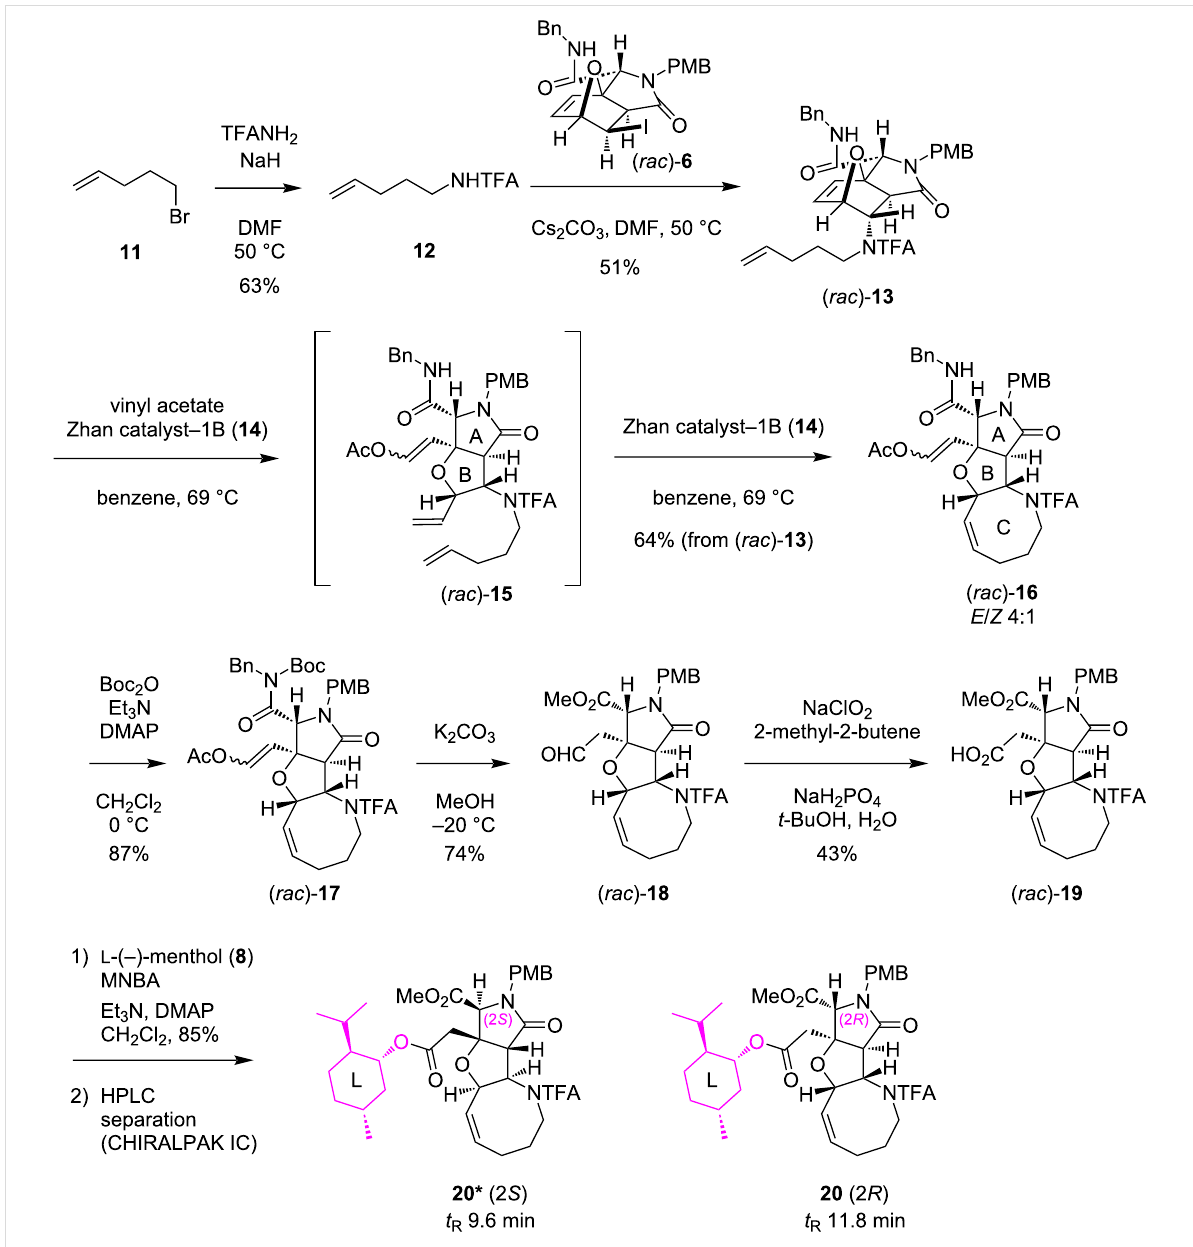
The N -Boc derivatization of ( rac )- 16 (87% yield), followed by alkaline methanolysis (74% yield) [17] and Pinnick oxidation (43% yield) [18-20], delivered carboxylic acid ( rac )- 19 .